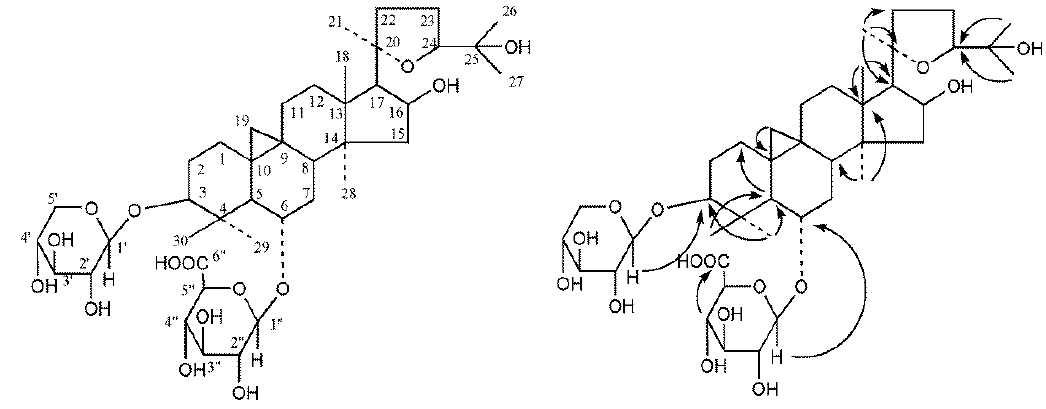
Figure 2. Structure and key HMBC correlations of compound 1 .